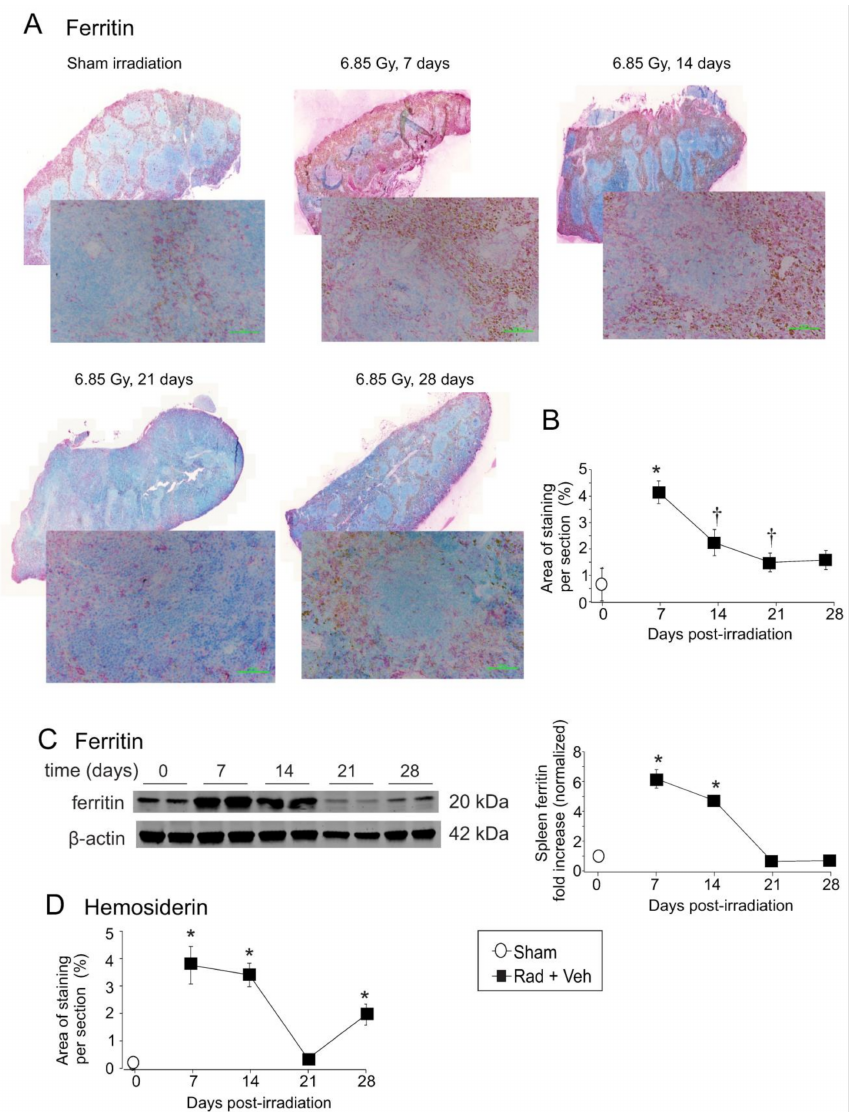
Figure 5. Total body irradiation results in increased ferritin and hemosiderin in the spleen. C57BL/6 mice were exposed to 6.85 Gy total body irradiation. At the indicated time points, mice were euthanized, and spleen tissue was obtained for immunohistochemistry and western blotting. ( A ) Spleen sections were stained for ferritin. Whole spleen images are shown from the Ziess Axioscan. Representative images from 3 separate slides are shown in the high-powered (30 × ) magnification. ( B ) Quantification of ferritin IHC staining. Graph shows means ± SEM, N = 3; † indicates p < 0.05 compared with 7 days post-irradiation. ( C ) Western blots of ferritin in total spleen tissue; blots were reprobed for β -actin as a loading control. Representative data are shown from n = 2 animals. Graph shows means ± SEM, n = 4 animals; * indicates p < 0.05 from control. ( D ) Quantification of hemosiderin staining in the spleen. Graph shows means ± SEM, n = 3; * indicates p < 0.05 compared with